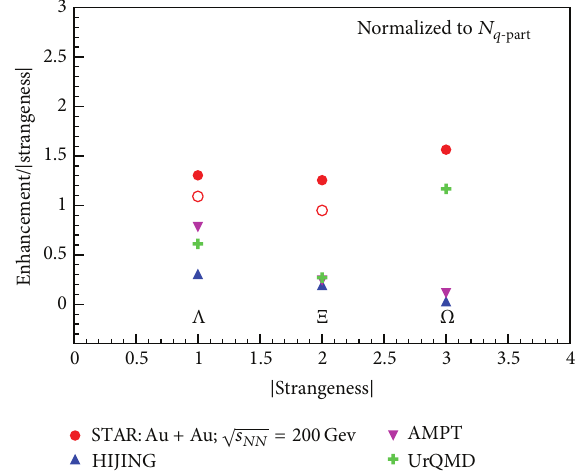
Figure 13: Midrapidity 𝑁 𝑞 and strangeness content normalized -part enhancement of multi-strange baryons as a function of strangeness content for Au + Au collisions at √𝑠 𝑁𝑁 = 200 GeV at RHIC. The filled and open circles are for the particles and the antiparticles, respectively.